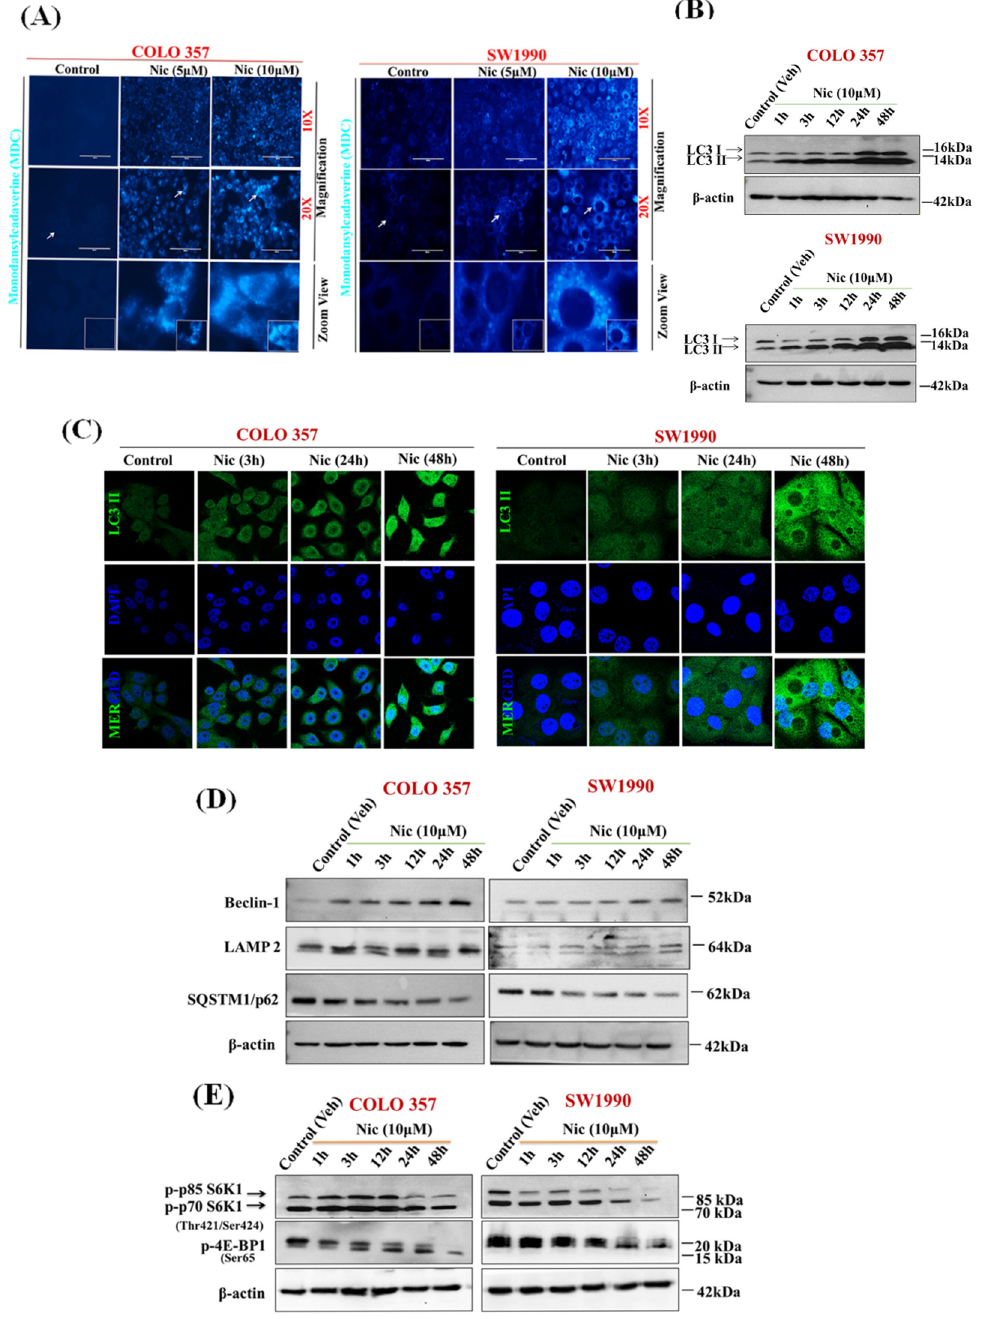
Figure 3. Nic stimulates autophagy through inhibition of mTORC1 signaling in PC cells. ( A ) Increased numbers of autophagic vacuoles represented by monodansylcadaverine (MDC) staining are seen with Nic (5 µ M or 10 µ M) by fluorescence microscope (10×; 20× magnification). ( B ) Representative Western blot images showing the expression of LC3I/II in COLO 357 and SW1990 cells treated with Nic (10 µ M) for various time points, i.e., 1, 3, 12, 24, and 48 h. β -actin was used as an internal loading control. ( C ) Representative images showing the LC3 punctate were observed by confocal microscopy. ( D , E ) COLO 357 and SW1990 cells were treated with Nic as described previously. Representative Western blot images showing the expression of a protein involved in mTORC1 dependent autophagy such as Beclin-1, LAMP2 and P62 ( D ) p-P70S6K1 and p-EBP1 ( E ), at different time points (1, 3, 12, 24 and 48 h) in COLO 357, SW1990 cells treated with Nic (10 μ M). Membrane was stripped and re-probed with β -actin to correct for loadings.